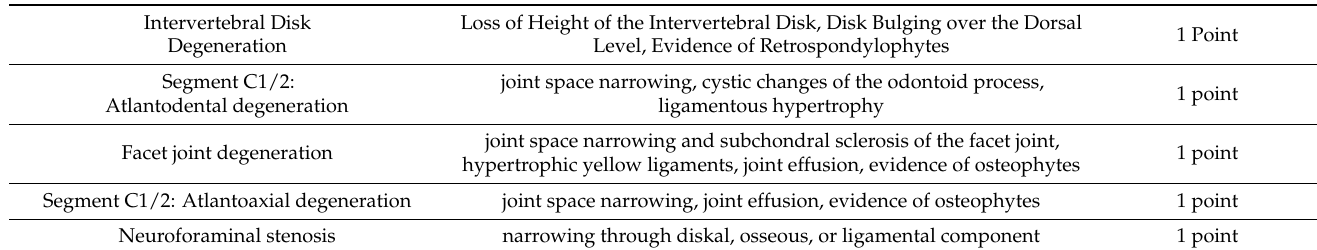
Table 2. Degeneration score (sum